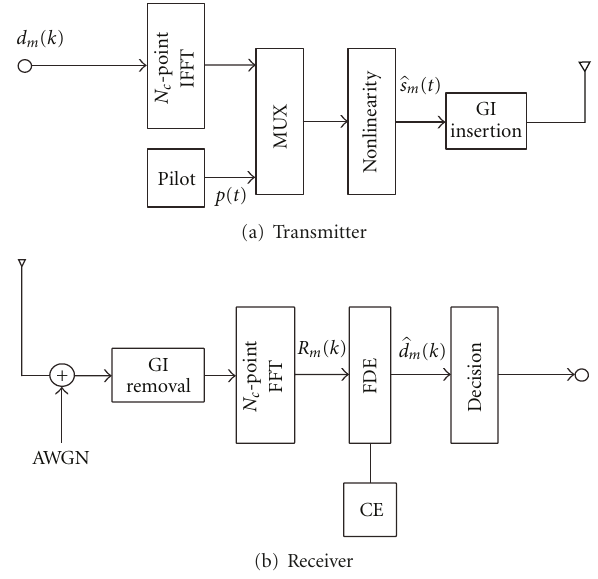
Figure 1: OFDM system